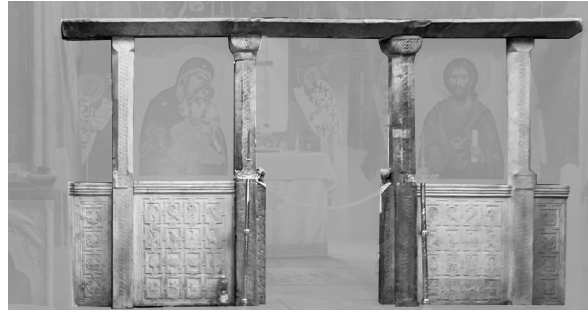
Figure 3. liturgical installation of St. Panteleimon in Nerezi The hypothesis for Monte Sorbo’s pergola considers the presence of a lintel at a height of 2 m. supported by four pillars of different sizes surmounted by squared capitals.